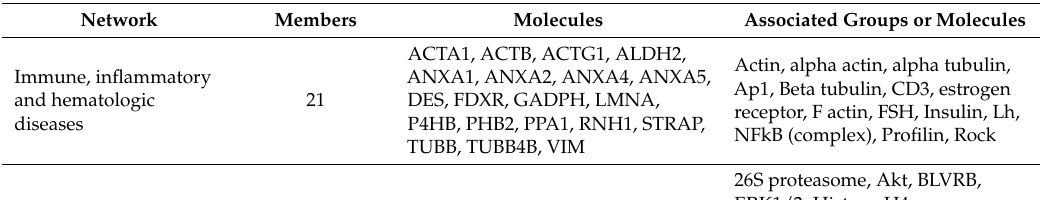
Table 3. Ingenuity Pathway Analysis of functional networks affected by selenium in young or senescent